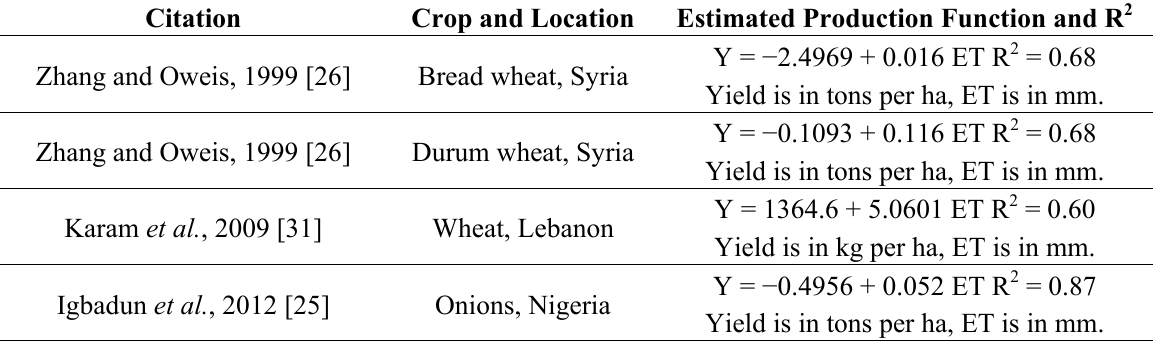
Table 3. Examples of linear crop production functions expressing yield as a function of evapotranspiration